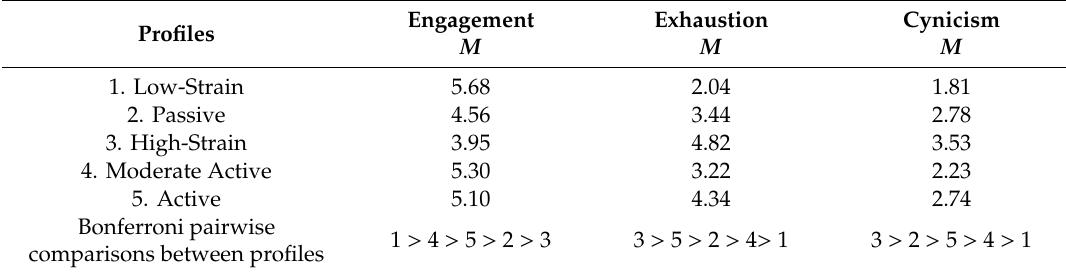
Table 4. Mean values of demands, control, engagement, exhaustion, and cynicism for each of the five